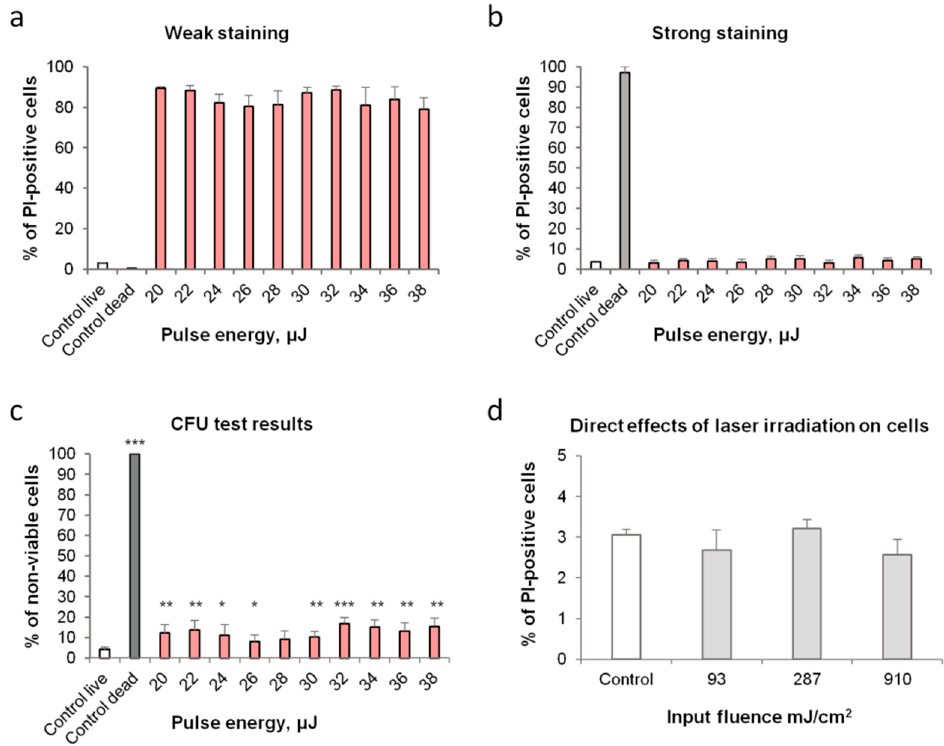
Figure 8. LIFT causes weak PI staining in most cells while resulting in minor, yet significant amounts of cell death not associated with strong PI staining. Laser irradiation alone does not have these effects. ( a )—Share of cells with weak PI staining in a population of LIFTed cells vs. the laser pulse intensity ( b )—Share of cells with strong PI staining in a population of LIFTed cells vs. the laser pulse intensity ( c )—Dependence of % of dead cells in a population of LIFTed cells (see Materials and methods) vs. the laser intensity ( p ≤ 0.1 (*), p ≤ 0.05 (**), p ≤ 0.01 (***)), Student’s t -test) ( d ) Dependence of % of dead cells in direct laser irradiation vs. the laser intensity.